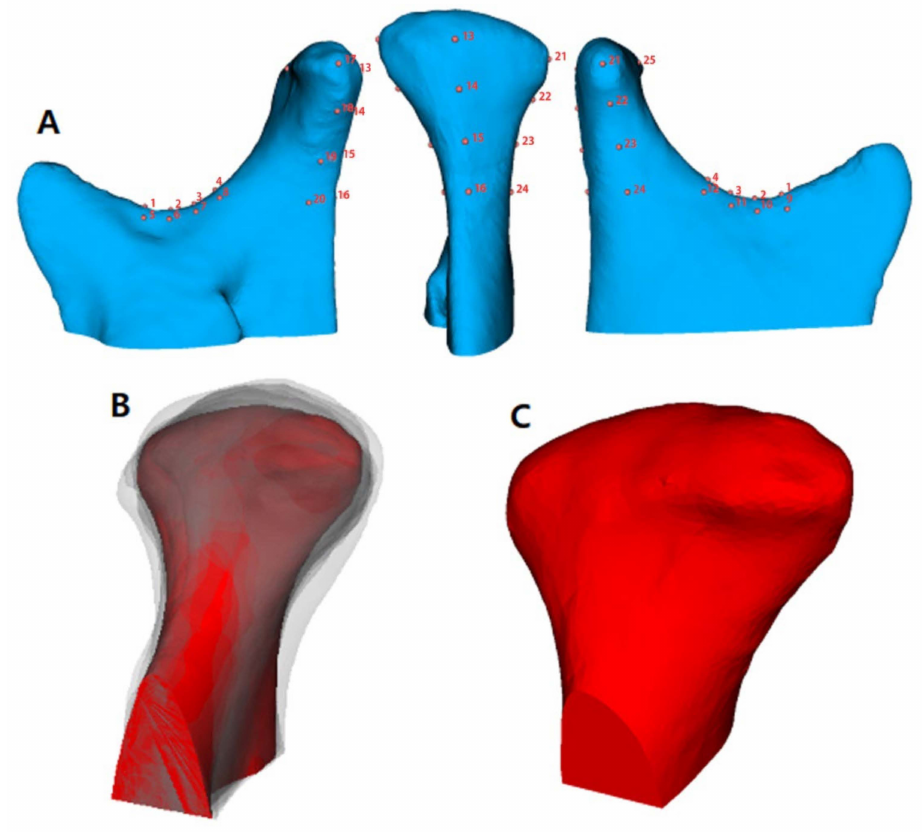
Figure 1. ( A ), 25 landmark registration for surface model approximation; ( B ), transparent overlays of the condyles approximated at the same coordinate; ( C ), cropped final surface